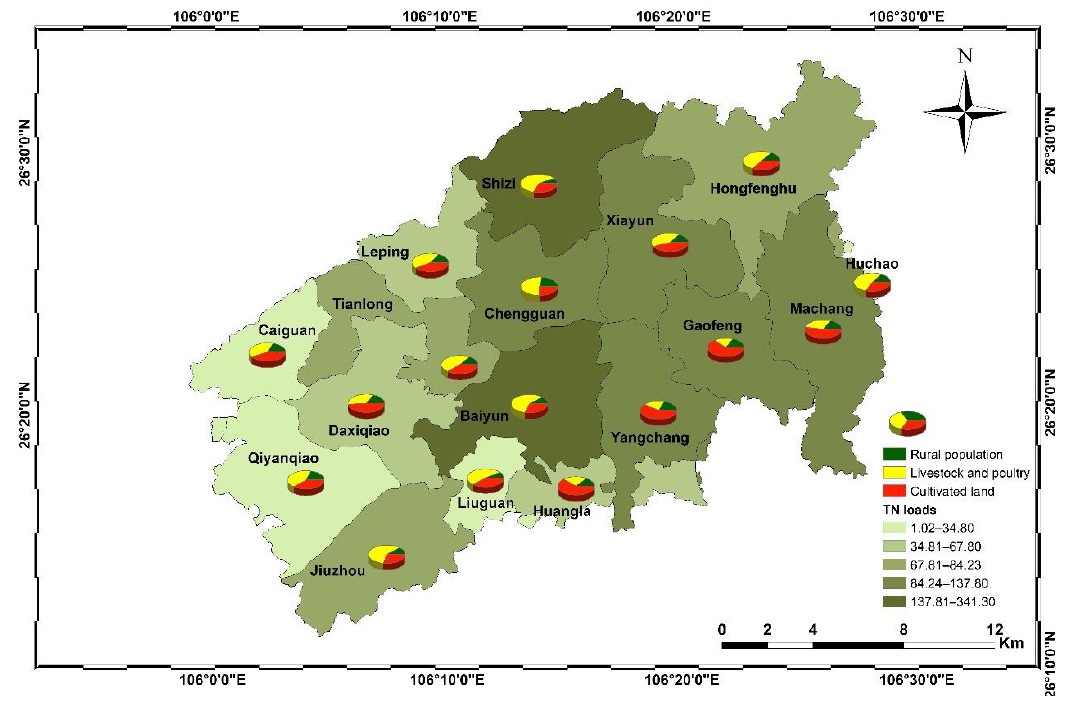
Figure 8. TN loads at the town scale in the Hongfenghu reservoir watershed.